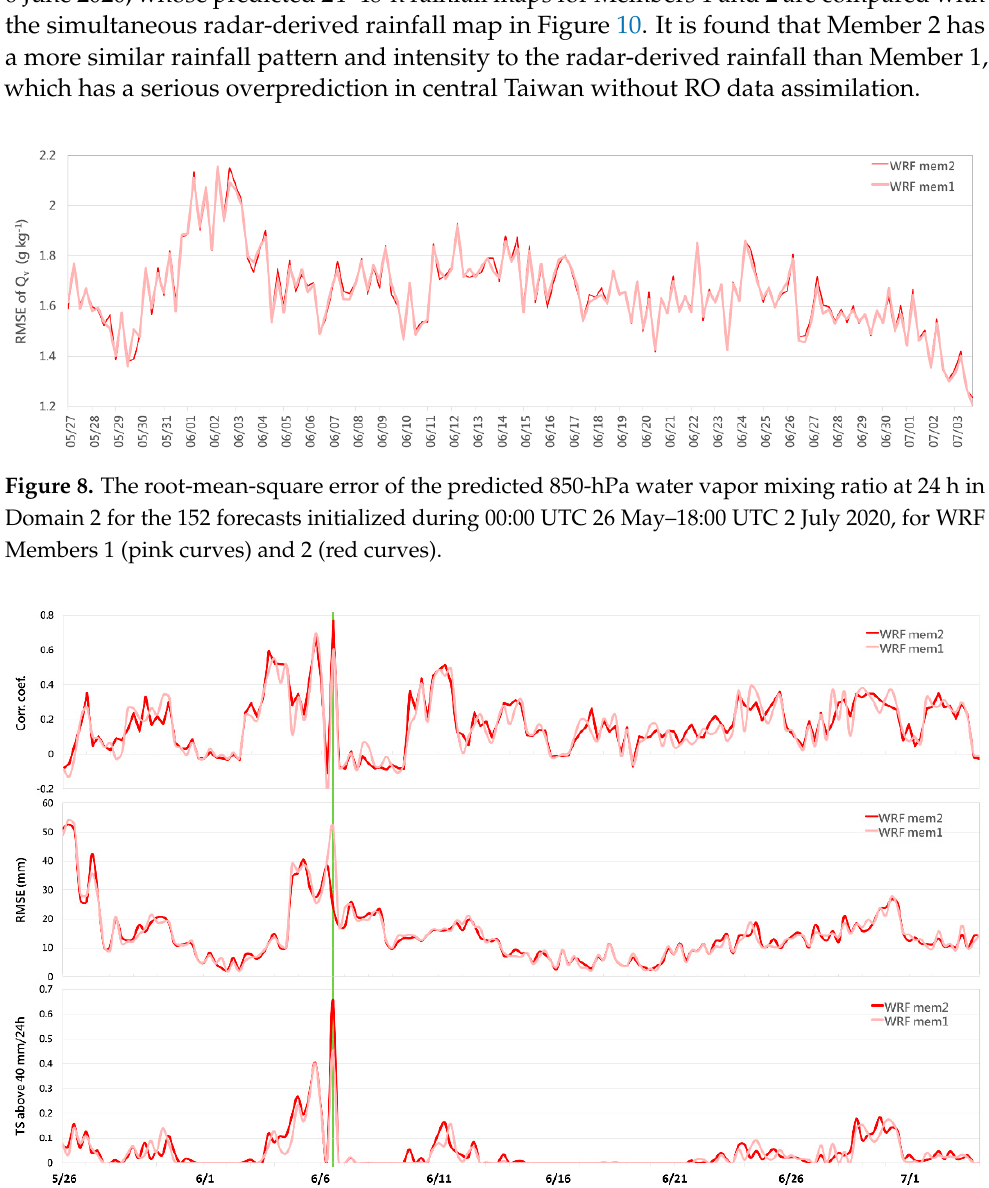
Figure 10. The maps of rainfall during 12:00 UTC 7 June–12:00 UTC 8 June 2020, for (from left to right) the radar-derived QPE data and the predicted 24–48-h rainfall of the forecasts initialized at 12:00 UTC 6 June 2020, for WRF Members 1 and 2. With respect to typhoon prediction, the track forecasts for Typhoon Hagupit, for which CWB issued a sea warning during 2–3 August 2020, are verified with the best track data at 6-h intervals. Figure 11a calculates the total track error within 72 h averaged over the 17 forecasts made by each WRF member. It is found that the positive effect of RO data assimilation is distinguishable since 48 h and more significant since 66 h. For a closer in- spection of the beginning 48 h, Figure 11b calculates the average total track, along-track, and cross-track error differences of Member 1 minus Member 2, where positive values represent the superiority of Member 2. The comparison reveals that RO data assimilation has a neutral impact on the moving speed and slightly positive impact on the moving